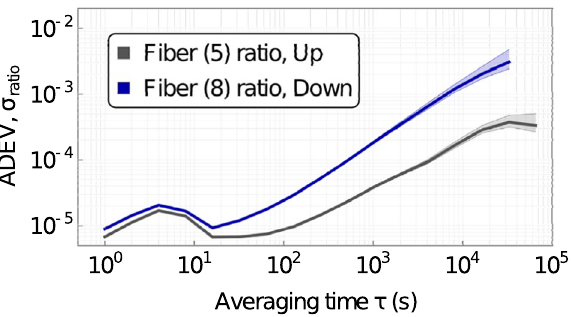
Figure 6. Overlapping Allan deviation of laser power stability as a ratio to total fiber output in a micro-optic module (normalized to total output power). Shown for the “Up” and “Down” fibers, we observe similar behavior at short times but differing slopes and relative drift at long times. The shaded regions show the minimum and maximum extent.